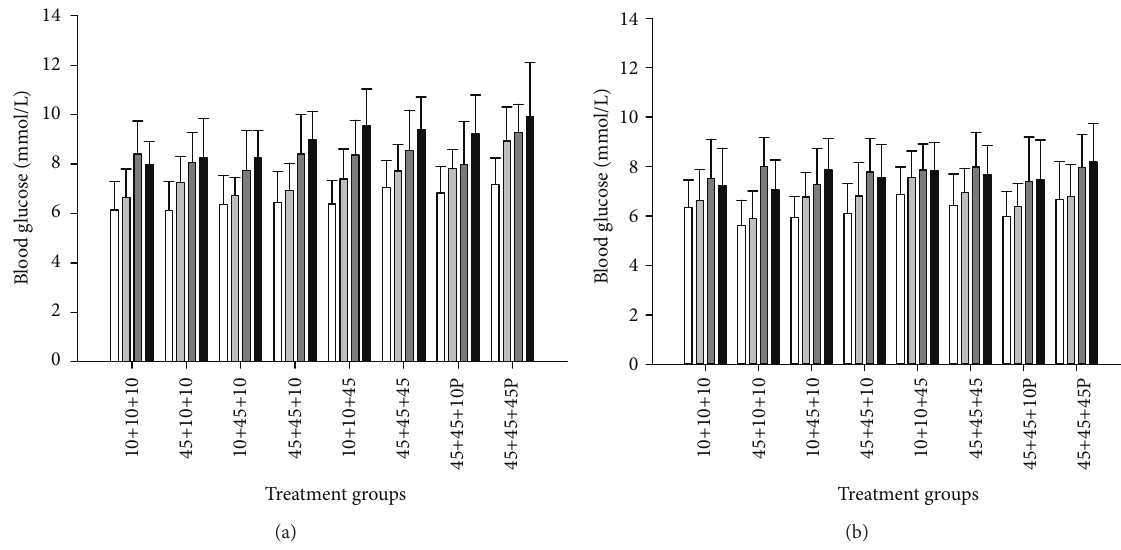
Figure 7: Nonfasted blood glucose levels (mmol/L, mean ± SD) for (a) Min/+ mice; females at 6 and 11 weeks and males at 6 and 11 weeks, (b) wild-type mice; females at 6 and 23 weeks and males at 6 and 23 weeks, shown for both genotypes with columns in white, light grey, dark grey and black color, respectively. P = PhIP. The experimental groups are as explained in the legend to Figure 1. 𝑛 = 9 – 46 .